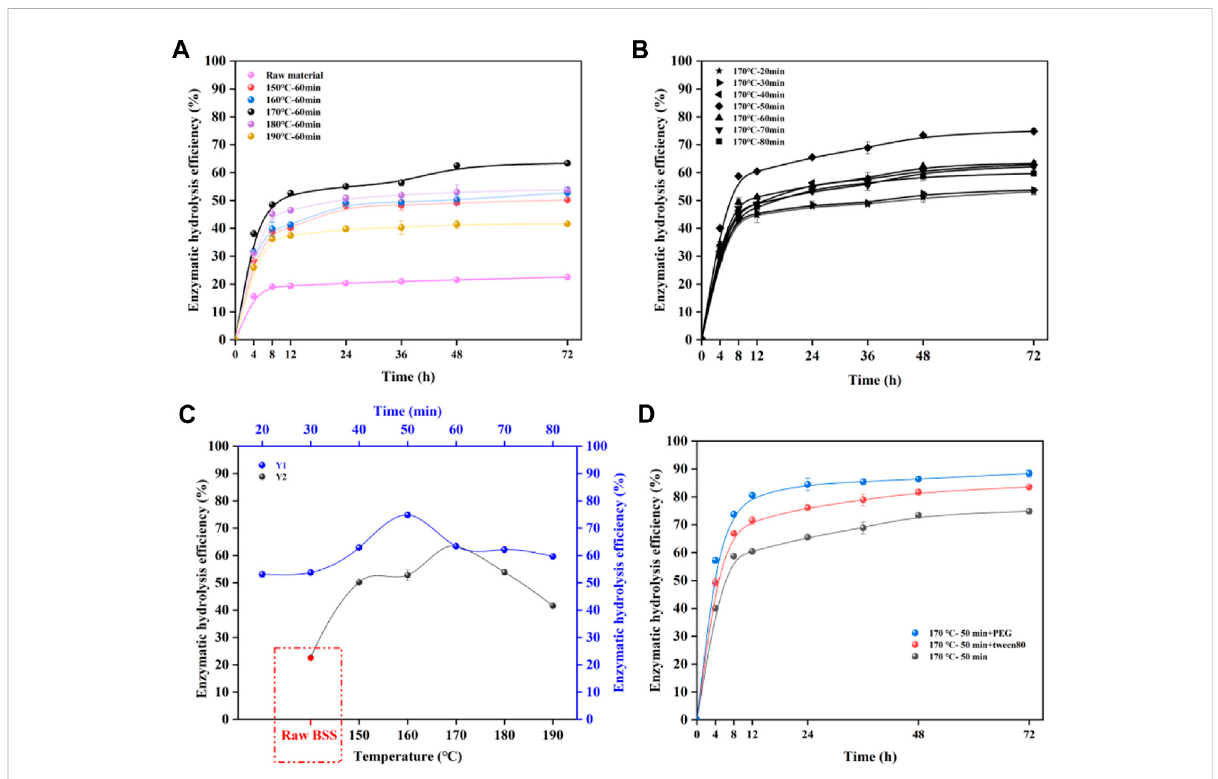
Figure 1C (Y1), the optimum reaction time can be found at 170 ° C. It was found that the substrate (170 ° C, 50 min)